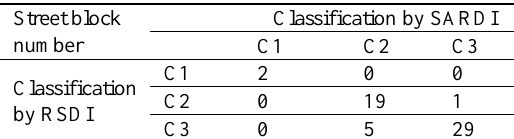
Table 1. The confusion matrix table for seismic damage classification from airborne SAR